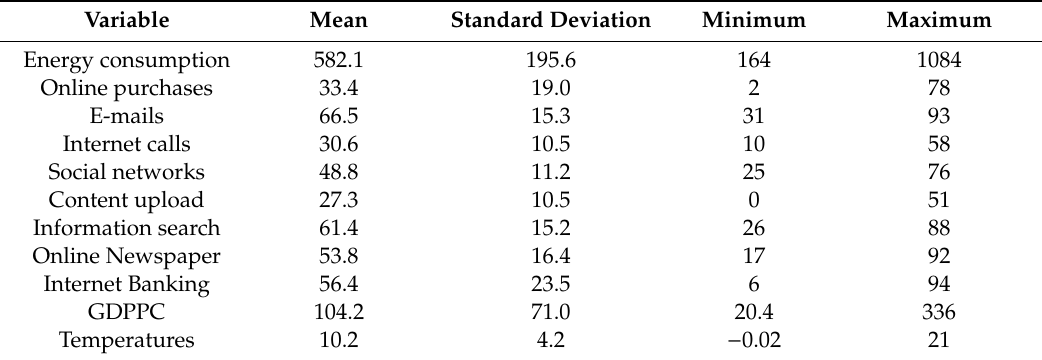
Table 5. Statistical variation of variables.